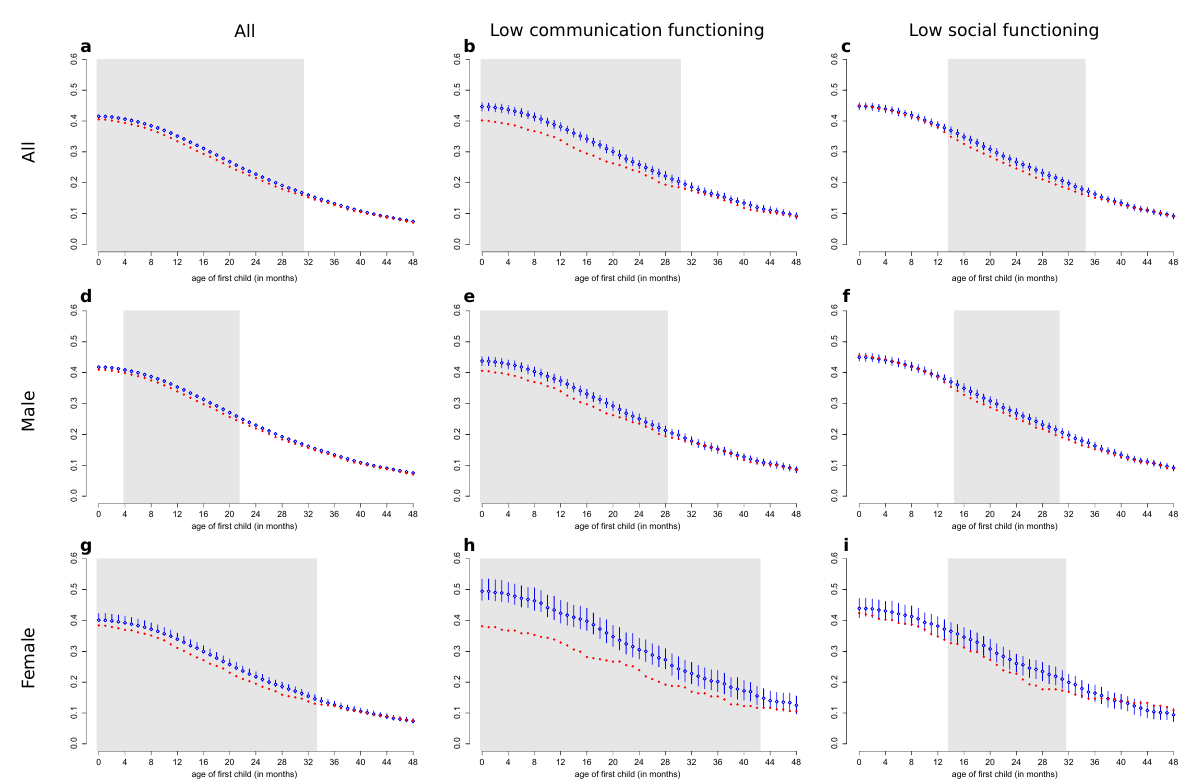
Figure 2: Proportion of mothers of firstborn children with (solid red circles) and without (open blue circles) autism who conceived a subsequent child at each given age of the first child, relative to those who have yet to conceive a second child, stratified by severity group and the gender of the first child. Shaded areas indicate significant effects of the first child’s autism status on subsequent